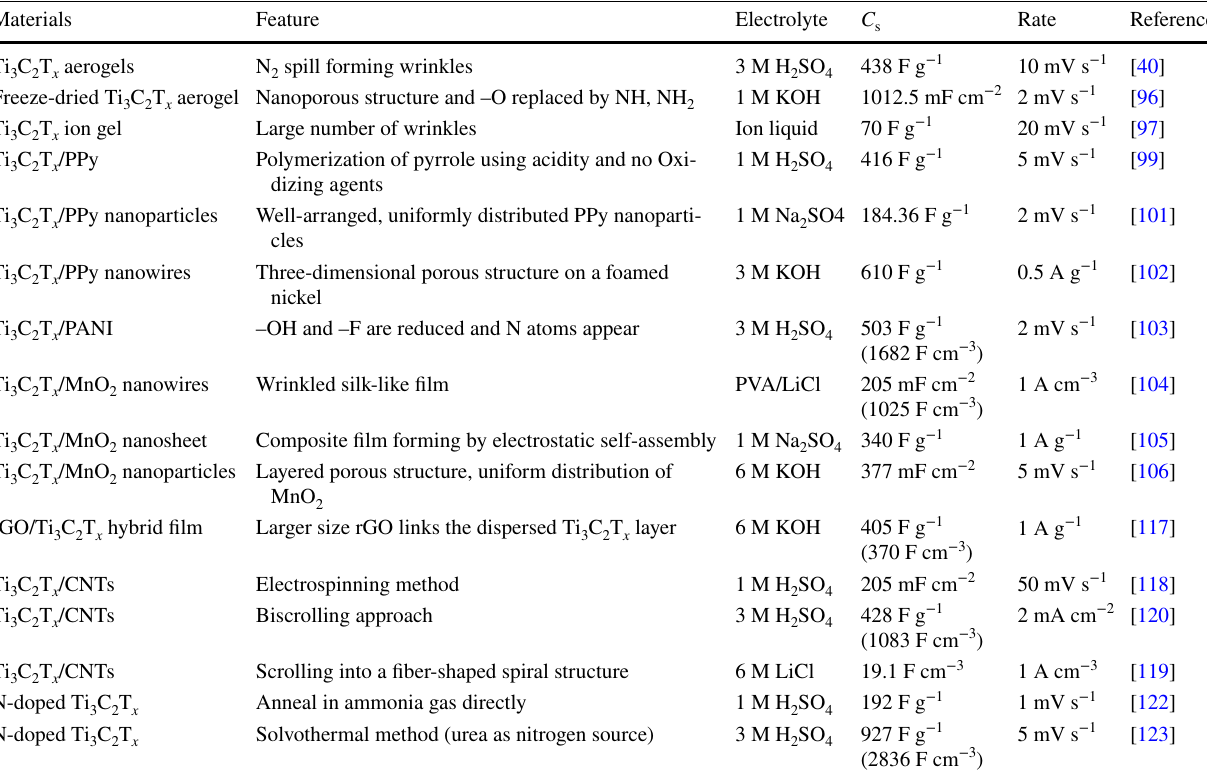
Table 1 Comparison of capacitance performance of Ti 3 C 2 T x -based materials, where C s is specific capacitance Materials